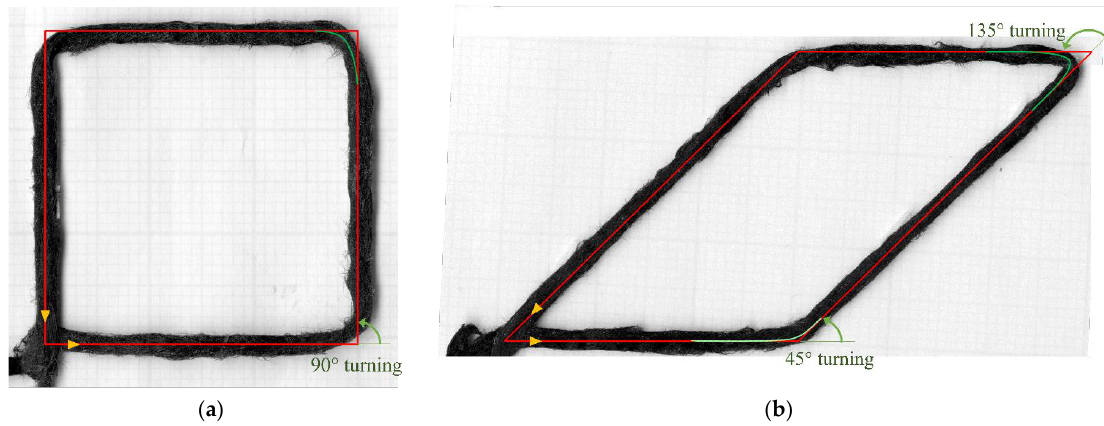
Figure 7. Preliminary shape study (before compensation): ( a ) 90° square; ( b ) parallelogram 45°/135°, green lines show the turning angle before changing printing direction.